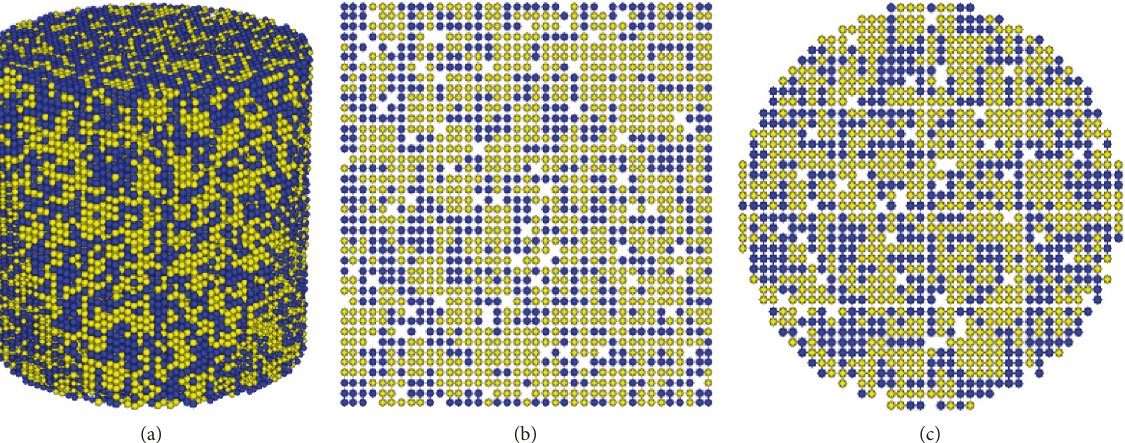
Figure 8: Numerical model of irregular